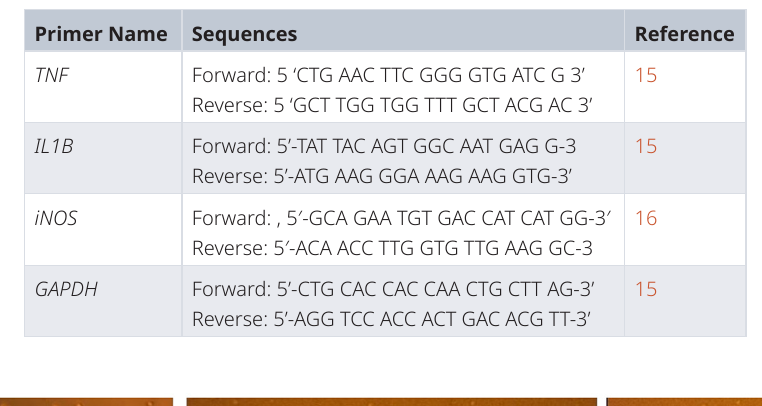
Table 1. Primers used in this study.